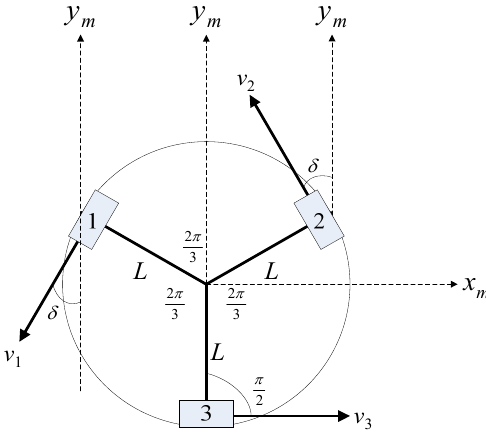
Figure 11. Omnidirectional WMR coordinate system.